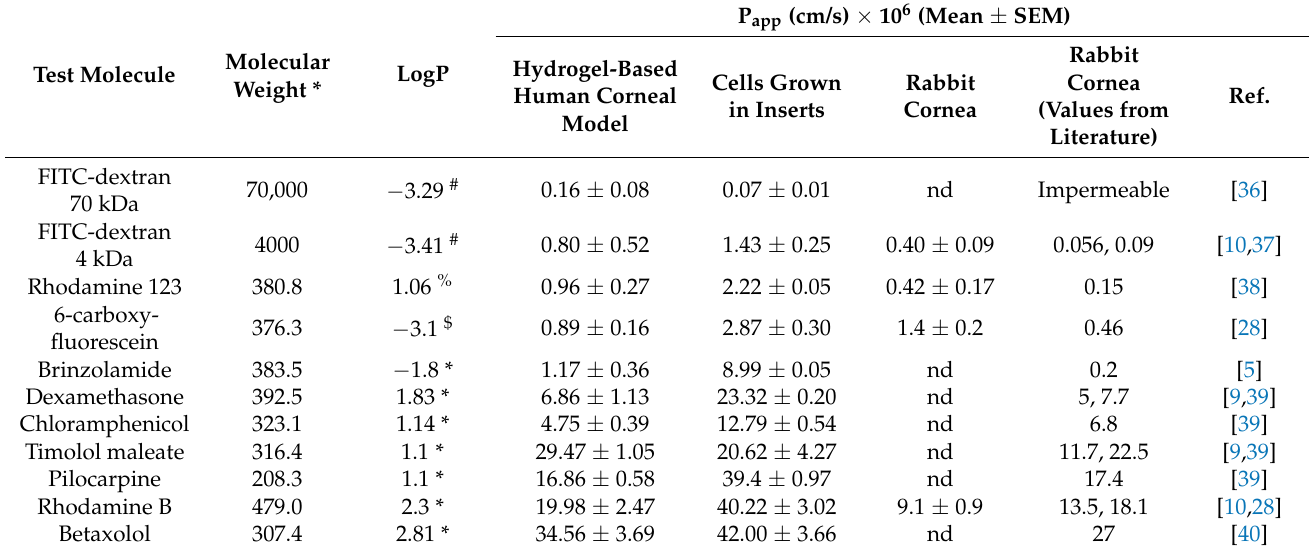
Table 2. P app values across the in vitro hydrogel-based human corneal model, cells grown in cell culture inserts, and rabbit cornea. P app (cm/s) × 10 6 (Mean ± SEM) Rabbit Molecular Hydrogel-Based LogP Test Molecule Cornea Cells Grown Rabbit Weight * Human Corneal (Values from in Inserts Cornea Model Literature)